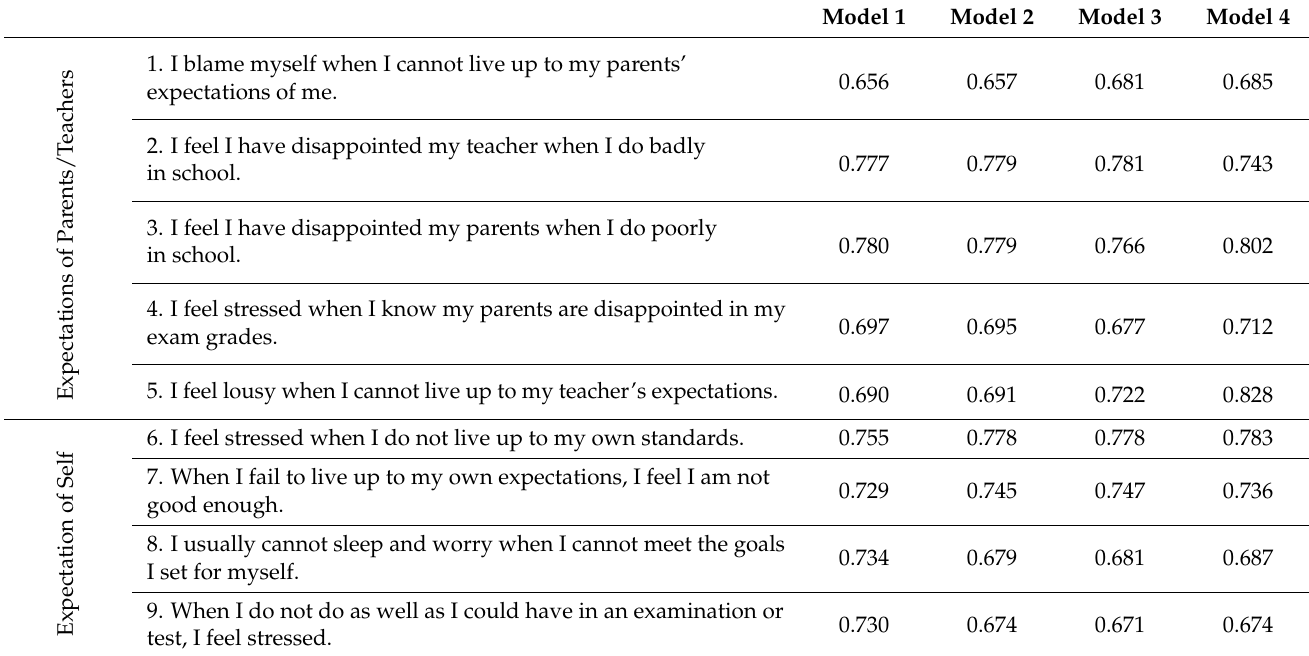
Table 3. Results of factor loading of AESI items in the four tested models ( n = 620).